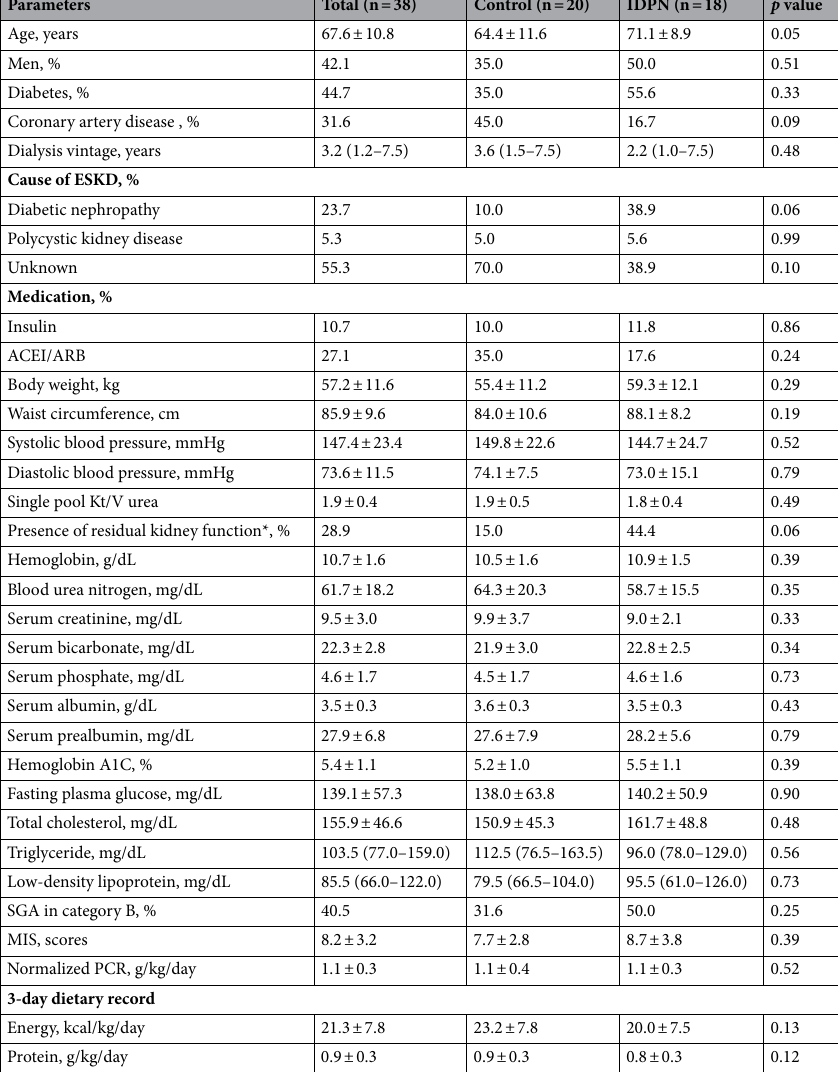
Table 1. Patient characteristics at baseline. ACEI Angiotensin converting enzyme inhibitor, ARB Angiotensin receptor blocker, BMI Body mass index, ESKD End-stage kidney disease, MIS Malnutrition inflammation score, PCR Protein catabolic rate, SGA Subjective global assessment. Data are presented as mean ± SD and median (25th–75th). P < 0.05 consider significantly different between two groups. *Residual kidney function defined as urine volume > 250